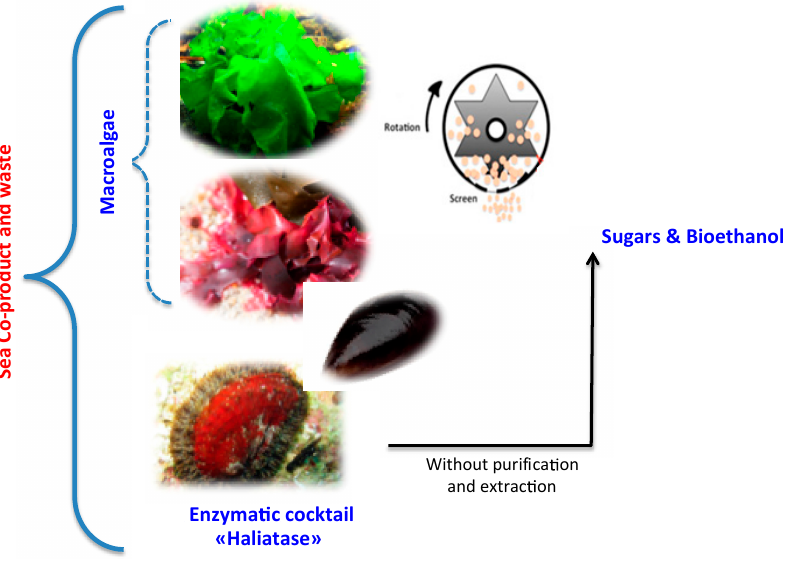
Enzyma c cocktail «Haliatase» Figure 1. Mechano-enzymatic pretreatment and deconstruction of macroalgae developed in this study.